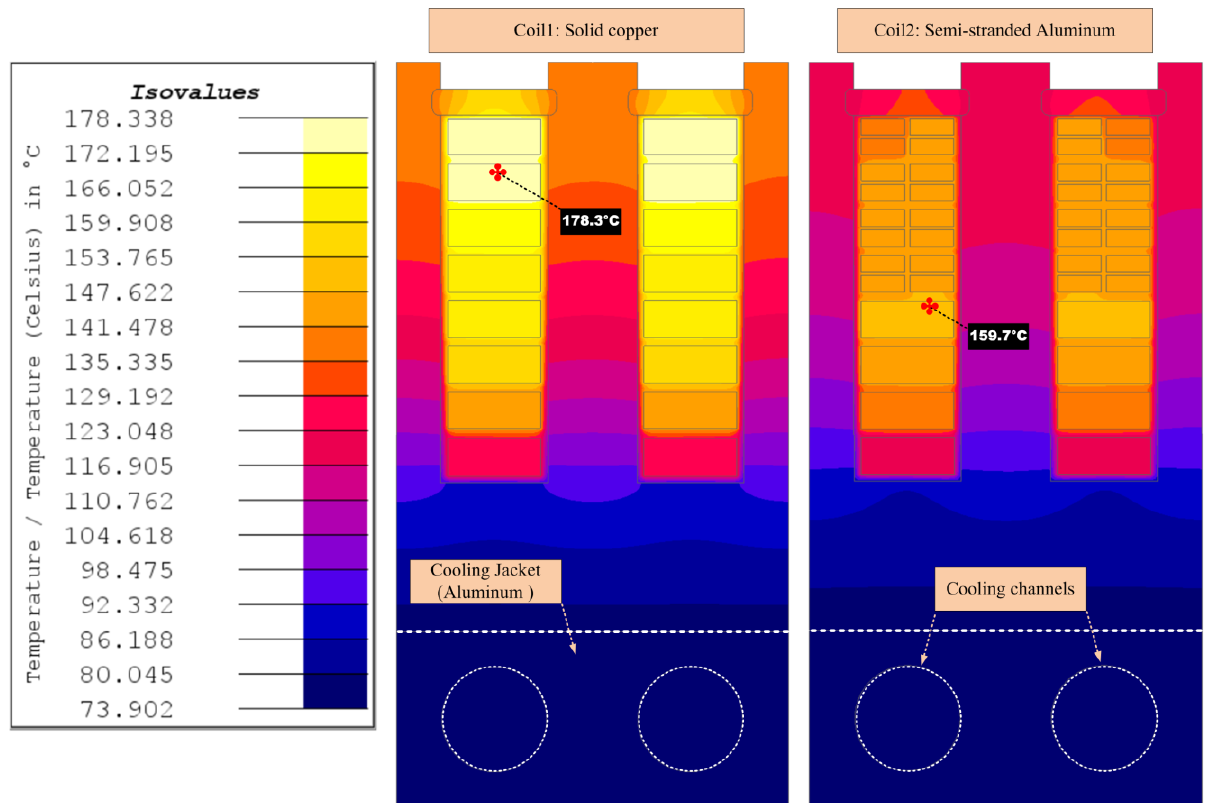
Figure 7. Comparison between the maximum temperature under the same driving cycle (WLTC).